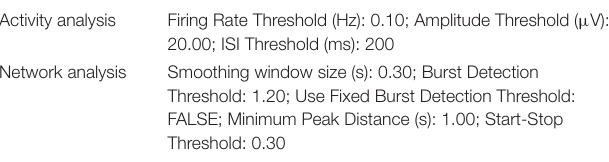
TABLE 1 | Summary of the parameters used for MEA analysis. Activity